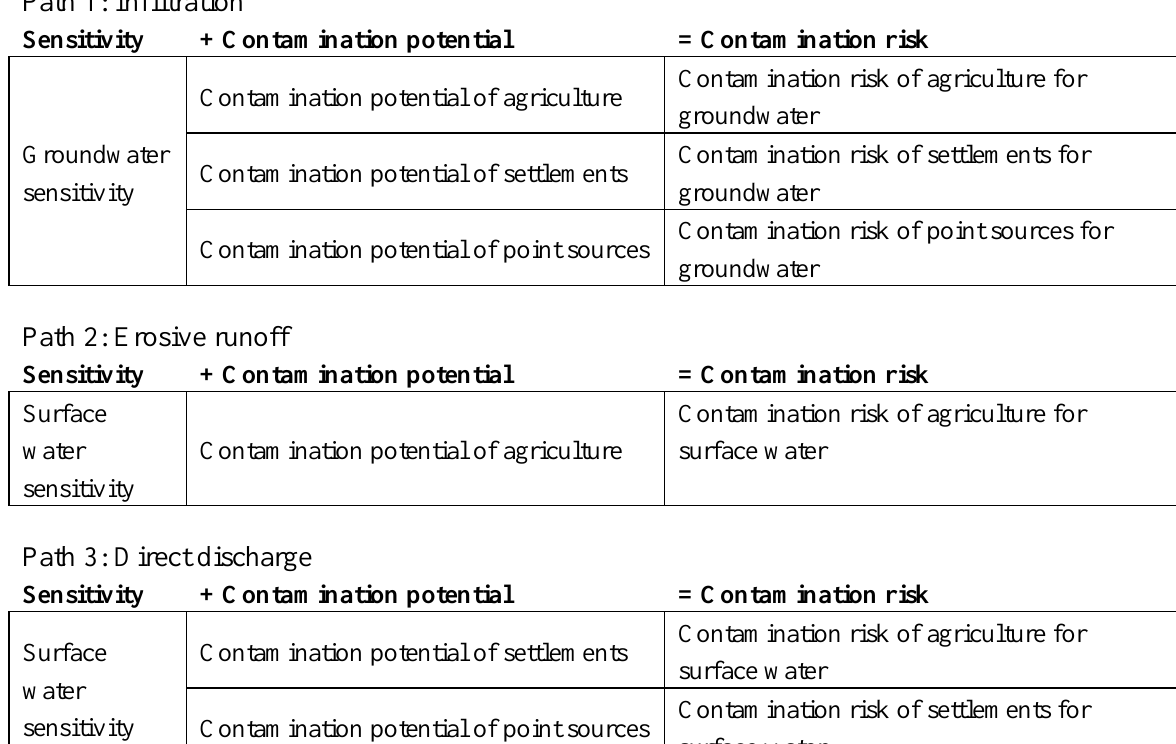
Figure 9. Aggregation of sensitivity of water resources and contamination potential to contamination